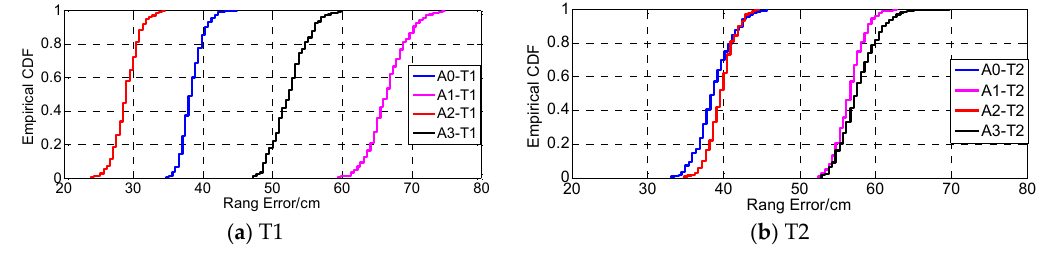
Figure 7. The cumulative distribution function (CDF) of the ranging error.